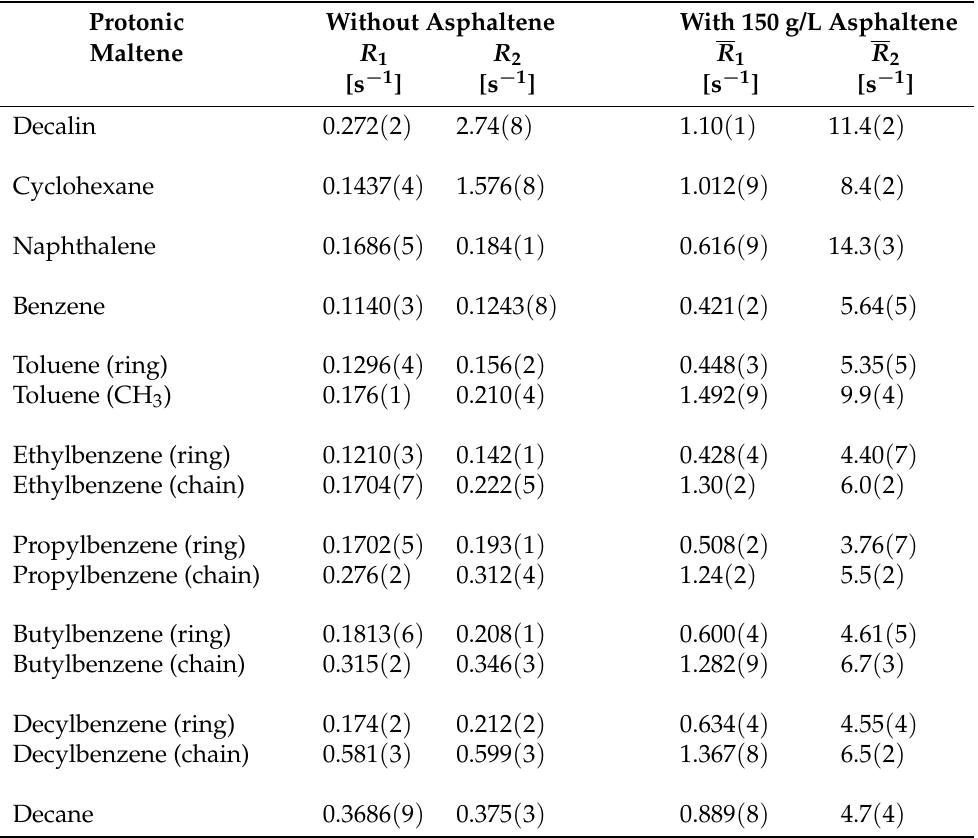
Table A2. (Mean) relaxation rate constants of the longitudinal ( R 1 ) and transverse ( R 2 ) relaxation of the protonic maltenes in absence and presence of the